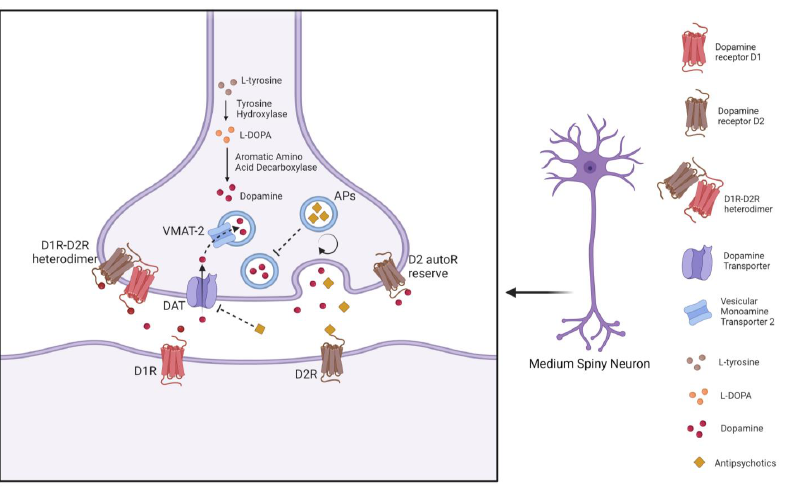
Figure 2. Presynaptic dopaminergic terminals and dopamine transporter in schizophrenia. The co- expression of D1R-D2R heterodimers at the presynaptic terminals in medium spiny neurons regulating calcium/calmodulin kinase II signaling directly in the nucleus accumbens [76]. The antipsychotic mech- anism of action involving the presynaptic dopaminergic terminal. In this regard, preclinical studies showed that antipsychotics could accumulate in the synaptic vesicles resulting in a significant release of extracellular drug concentrations that inhibit presynaptic function [78,79]. Treatment with antipsychotics could generate an intracellular drug store co-released by vesicles together with endogenous dopamine, resulting in the inhibition of presynaptic voltage-gated sodium channels, which regulate dopamine release with an autoinhibitory effect. The formation of a ‘reserve’ of presynaptic D2 autoreceptors that interact mainly with endogenous dopamine, whereas postsynaptic D2Rs could be mostly occupied by antipsychotics. The blockade of DAT has been responsible for the restoration of synaptic dopamine levels in chronic treatment with antipsychotics. Dopamine uptake by VMAT-2 showed to be relevant to D2R activation, suggesting its pharmacological modulation as a therapeutic target in schizophrenia. L-DOPA, Levodopa; D1R, Dopamine receptor D1; D2R, Dopamine receptor D2; DAT, Dopamine transporter; VMAT-2, Vesicular monoamine transporter 2; APs, Antipsychotics; D2 autoR, Dopamine D2 autoreceptor. Created with BioRender.com on 7 March